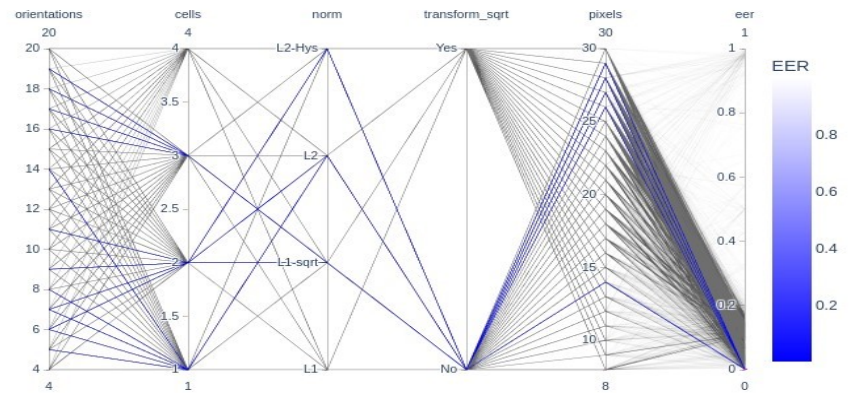
Figure 6. Parallel Coordinates Plot of the Hyperparameters.